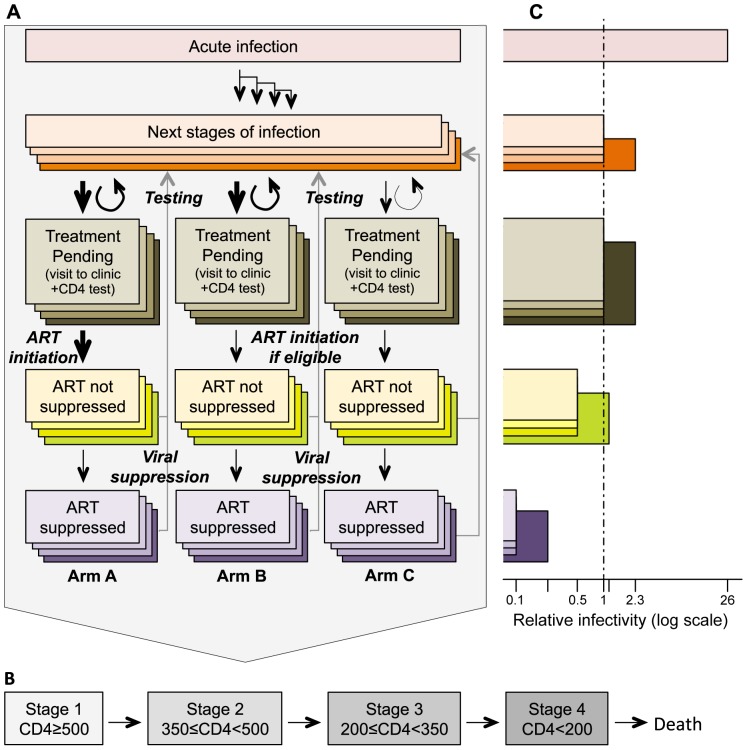
Model structure for infected individuals.
A. Flow diagram of the model. The model describes progression through different stages of natural history and treatment. Arrows depict the different flow rates between compartments. Once infected, individuals enter an early/acute infection stage and then progress to death through 4 stages of infection shown in b. At any stage after acute infection, individuals can get HIV tested, following which a proportion of individuals will decide to seek care. Those individuals then enter the “treatment pending” stage, during which they visit the clinic and get assessed towards ART eligibility. Once assessed, all those eligible initiate treatment. Once on treatment, individuals go through a first phase during which viral load is not fully suppressed, before becoming successfully treated, that is, having a negligible viral load. Individuals on ART can drop out of or fail treatment; they then go back to the pre-test stages. B. Flow diagram of the four stages of infection following acute infection and leading to death. Those stages are defined by the level of CD4 in cells/mm3. Individuals can only move from a higher to a lower CD4 count. The rate of progressing through those stages is different for treated and untreated individuals (see File S1). C. Relative infectivity (on the log scale) of the different stages, compared to an undiagnosed individual with CD4≥350, not in acute infection. Individuals in acute infection and stage 4 (CD4<200) have an increased infectivity. Individuals on ART have a decreased infectivity.